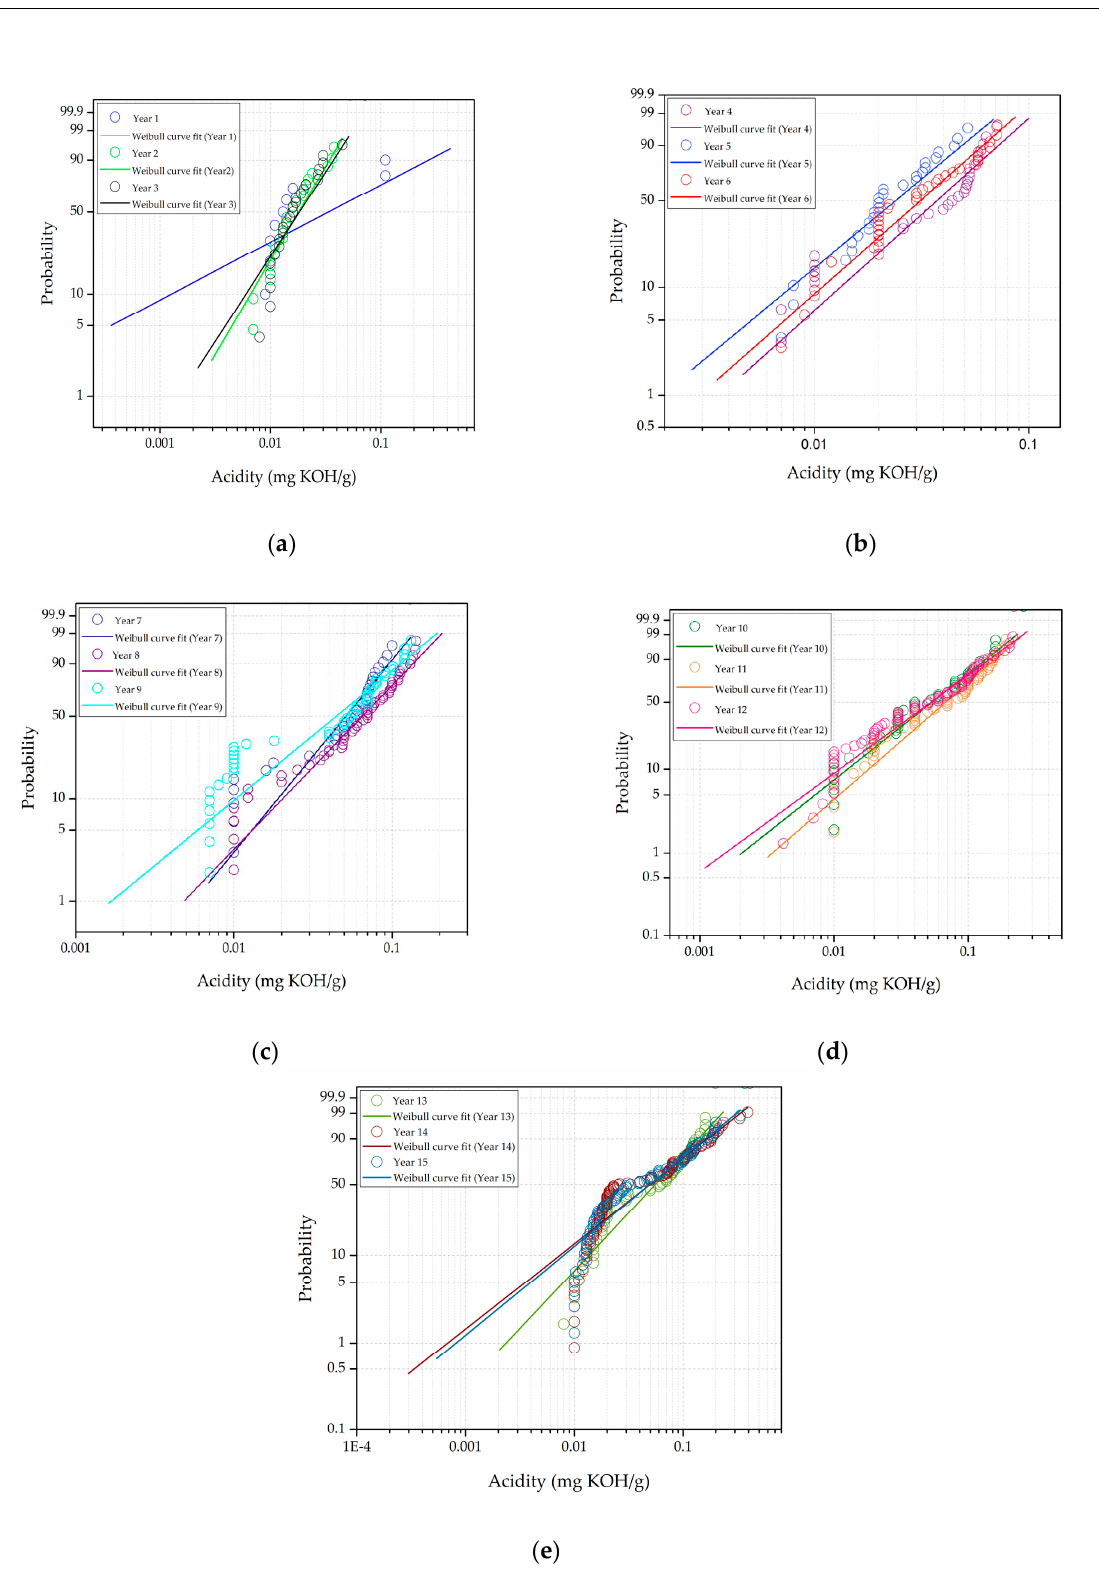
Figure 3. Weibull distribution probability plot for acidity from year ( a ) 1 to 3; ( b ) 4 to 6; ( c ) 7 to 9; ( d ) 10 to 12; and, ( e ) 13 to 15.